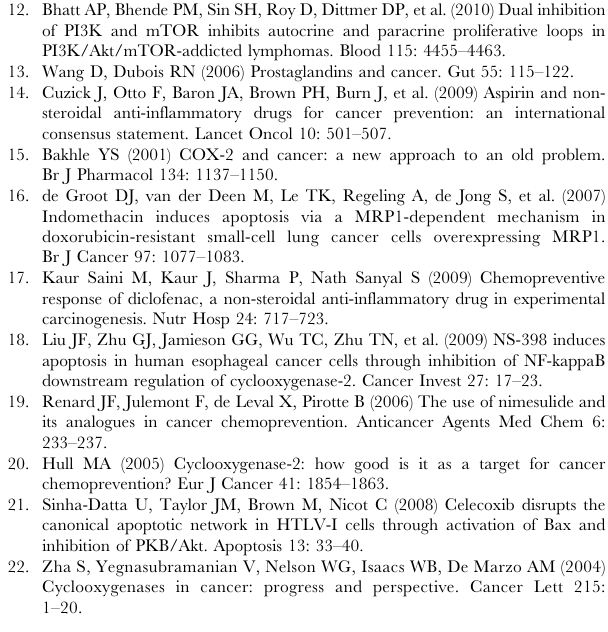
Figure S1 Effect of nimesulide on KSHV infected endothelial cells. ( a-c ) TIVE (a), TIVE-LTC (b), and HMVEC-d (c) cells were serum starved for 48 h and treated with the indicated concentrations of nimesulide and cell proliferation was measured by MTT assay at day 1 (1d; a), day 3 (3d; c), and day 4 (4d; d). The cells were neither replenished with fresh media nor supplemented with the drugs. Each experiment was done in tripicates, and each point represents the average 6 s.d. from three independent experiments. One-way ANOVA with Tukey’s posthoc comparison analysis (p , 0.05) was used to determine whether the drug treatment induced a statistically significant difference in the proliferative indexes at 1d, 3d, and 5d compared to untreated cells of the respective cell